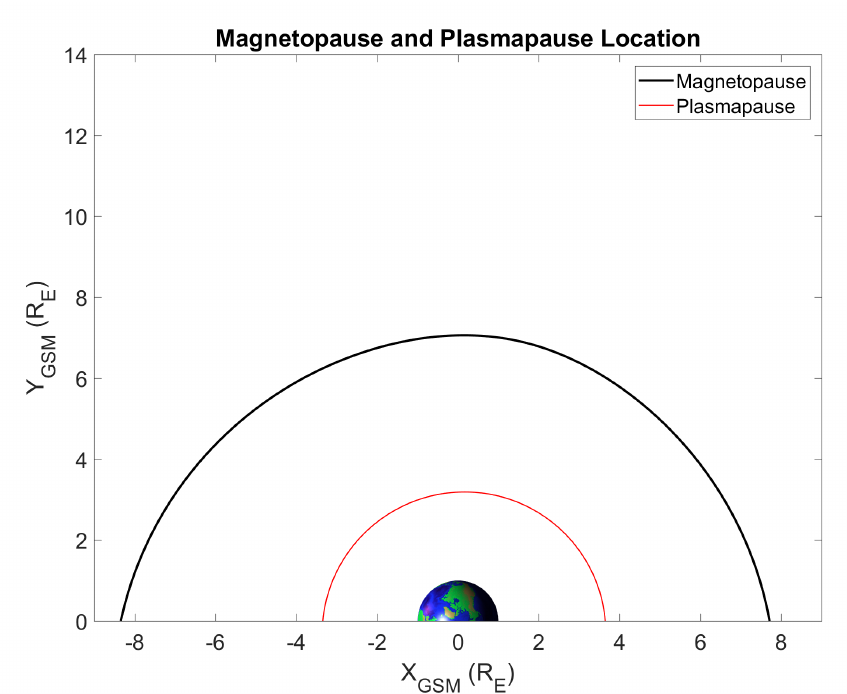
Figure 6. Magnetopause (black line) and plasmapause (red line) profiles as evaluated using the Tsyganenko T01 and the Liu (2014) models, respectively. The reference frame is the GSM. The SW parameters used in the T01 model are: P = 8.7 nPa; B y , IMF = 4.5 nT; B z , IMF = − 16.8 nT; Dst = − 174 nT. The Dst index value used in the plasmapause model is the same as in T01.